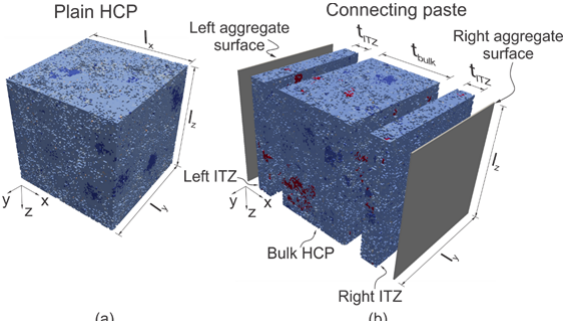
Figure 1. Geometry of the samples: (a) plain HCP and (b) connecting paste with ITZs and bulk